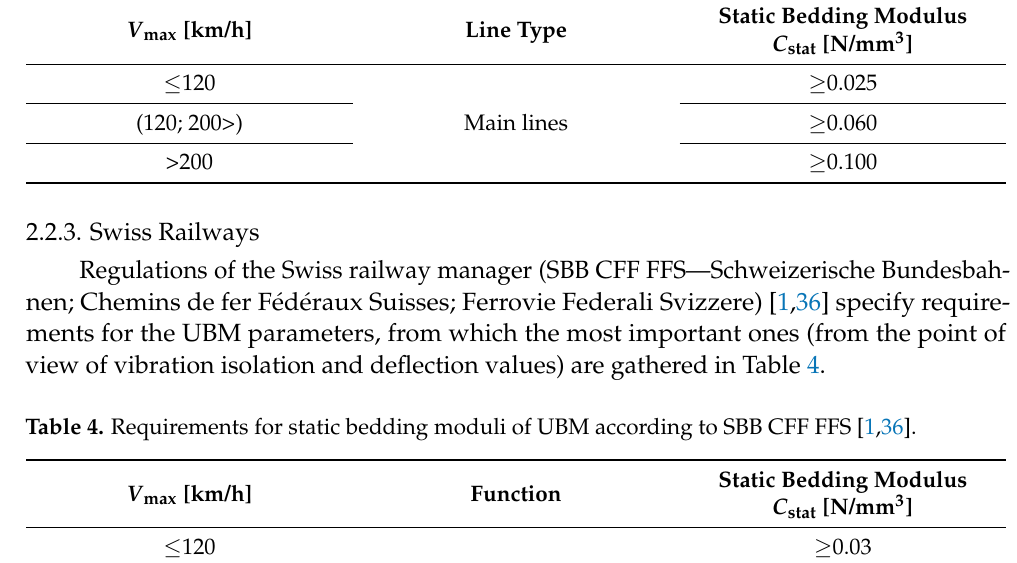
Static Bedding Modulus